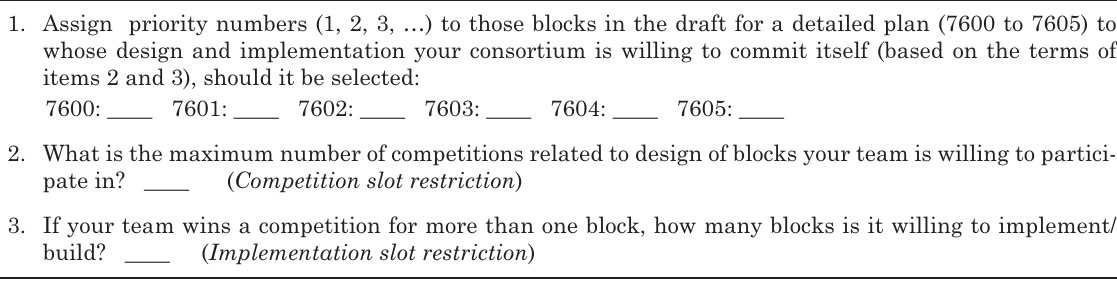
Table 3. Basic allocation data requested from consortia 1. Assign priority numbers (1, 2, 3, …) to those blocks in the draft for a detailed plan (7600 to 7605) to whose design and implementation your consortium is willing to commit itself (based on the terms of items 2 and 3), should it be selected: